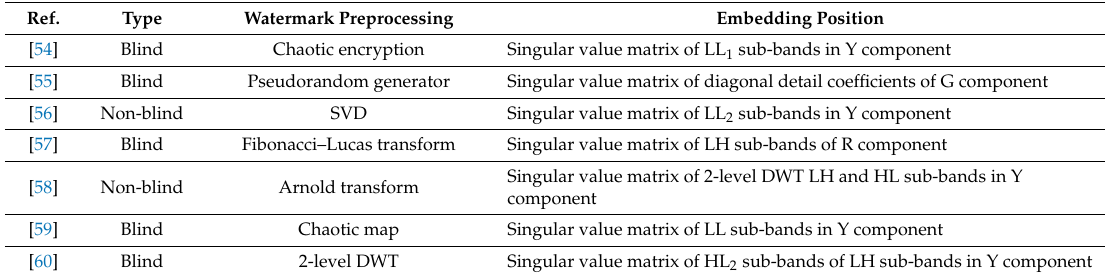
Table 5. Summary comparison of several SVD-based watermarking algorithms.